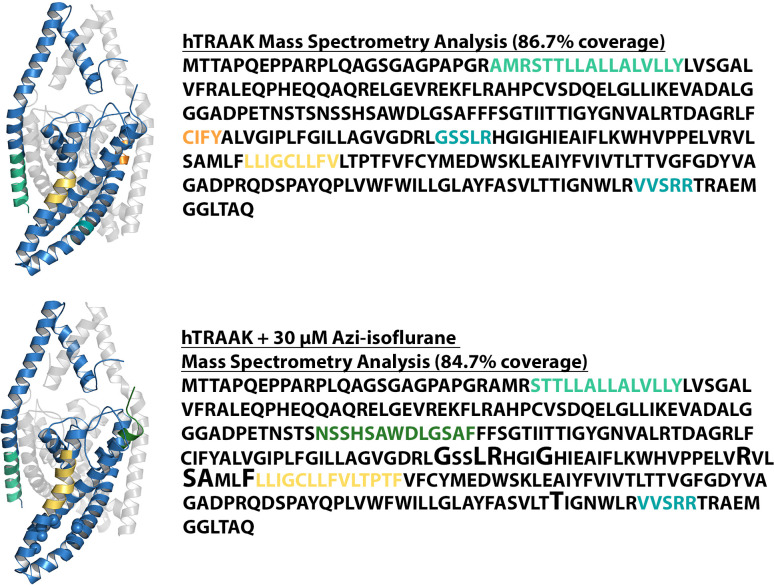
Mass spectrometry (MS) analysis of purified human TRAAK.Results of MS analysis of TRAAK in the absence of reaction with azi-isoflurane (top) or following reaction with 30 μM azi-isoflurane (bottom). Regions positively identified by MS analysis are shown in blue in the TRAAK structural model (PDB ID 4WFE) and in black font in the sequence data. Regions absent from MS data are displayed in matching color in both the structural model and the sequence data. TRAAK residues homologous to TREK1 positions that exhibit high isoflurane occupancy in MD simulation are displayed as spheres in the structural model of TRAAK and are denoted in the sequence data by an enlarged font. All these residues are identified by MS, but none show evidence of azi-isoflurane labeling. A group of residues in the C-terminal region of TRAAK (marked in gray in the sequence data) were absent from our MS analysis but are not present in the TRAAK structural model.